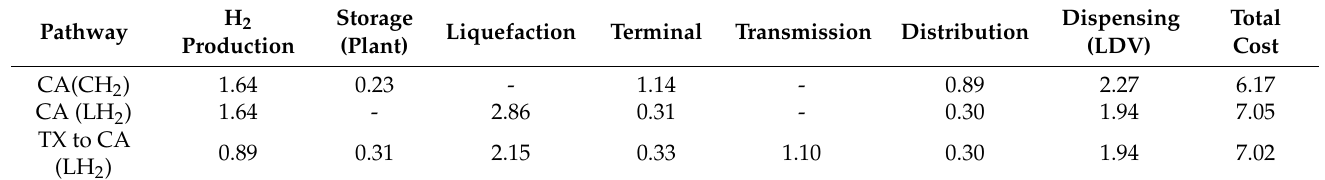
Table 4. Cost comparison between CH 2 and LH 2 based on the specific scenarios (USD/kg)